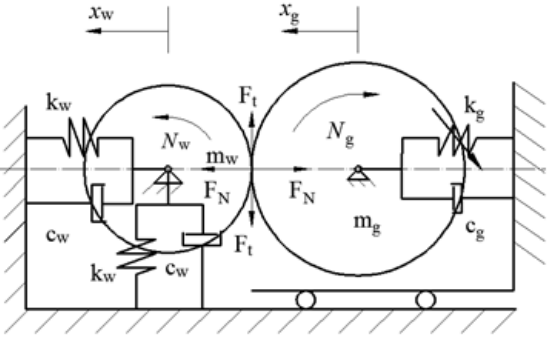
Fig. 1. Kinematics of roll grinding process removed and a grinding force is produced between the roll and